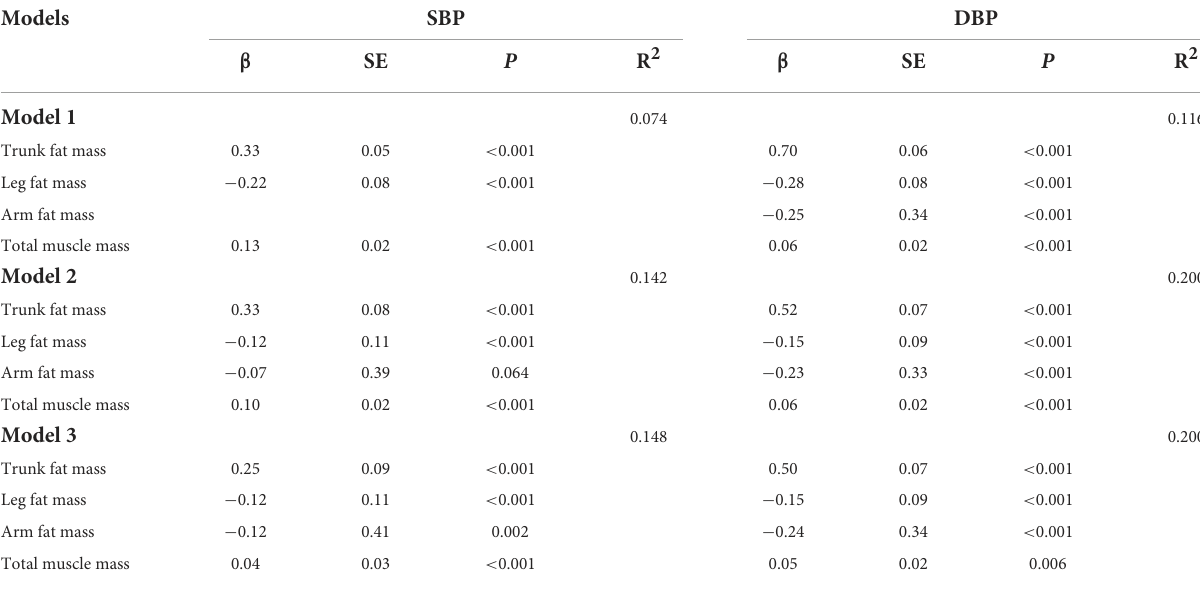
TABLE 2 Impact of various components of body composition on BP in